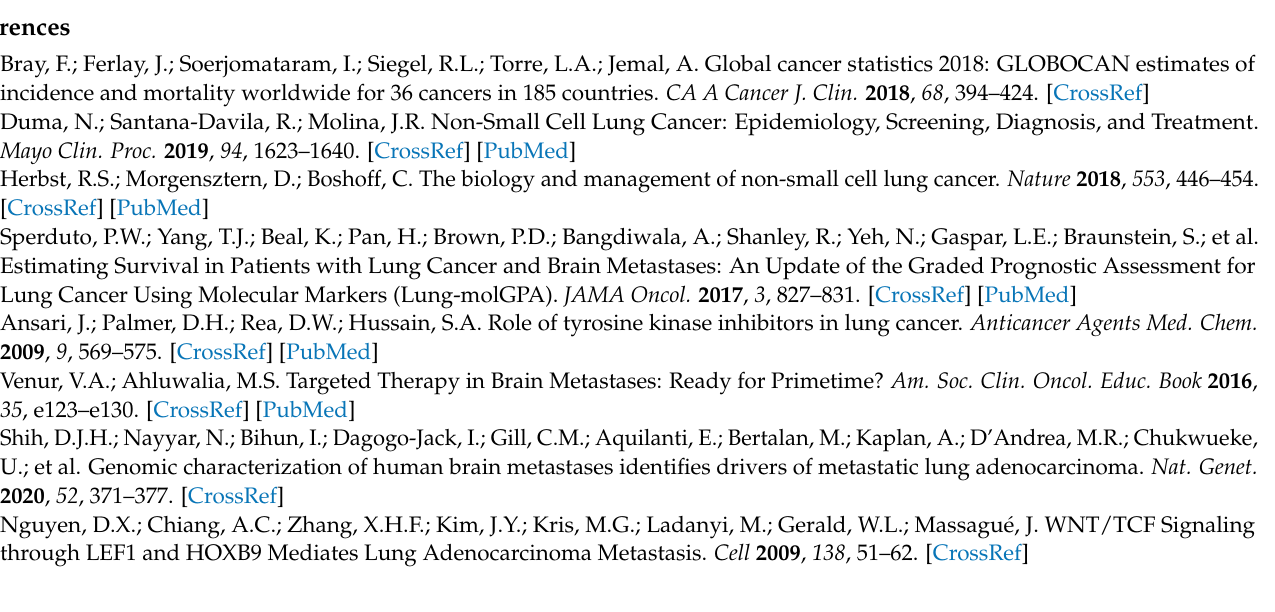
Table S1: The primer sequences used in this part of the experiment are as follows; Table S2: The specific shRNA sequence construction framework is as follows; Table S3: PCR amplification primers for overexpression CERS1 were showed in the following